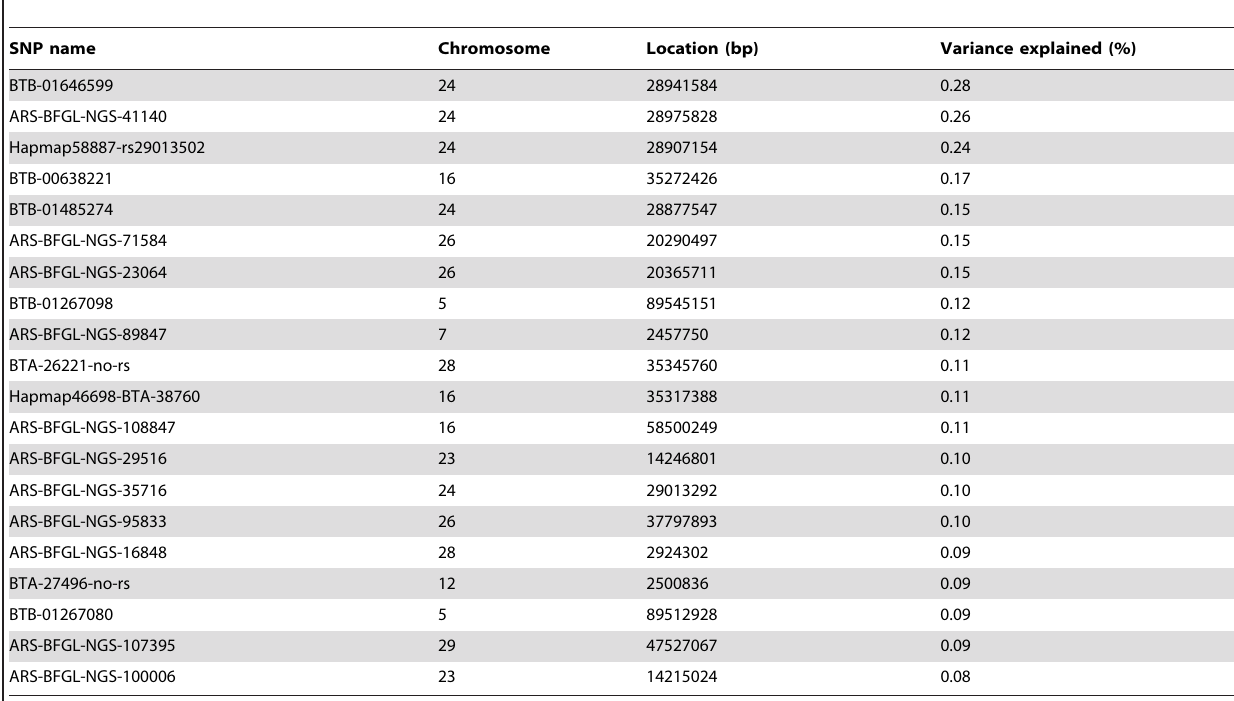
Table 2. The 20 loci with the largest proportion of SNP variance explained for rectal temperature using 3-SNP sliding